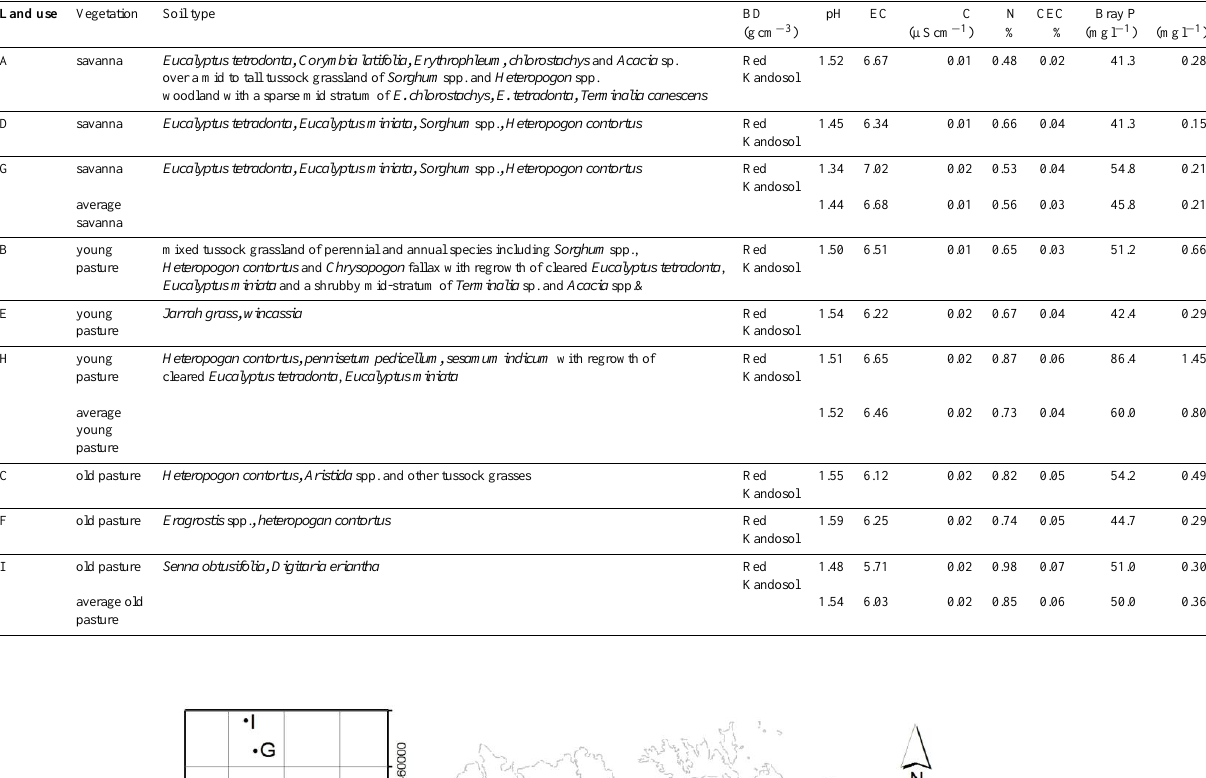
Table 1. Site details from the manual chamber sites. Soil samples were taken from 0–10cm, values are the average of triplicate samples. Landuse Vegetation Soiltype